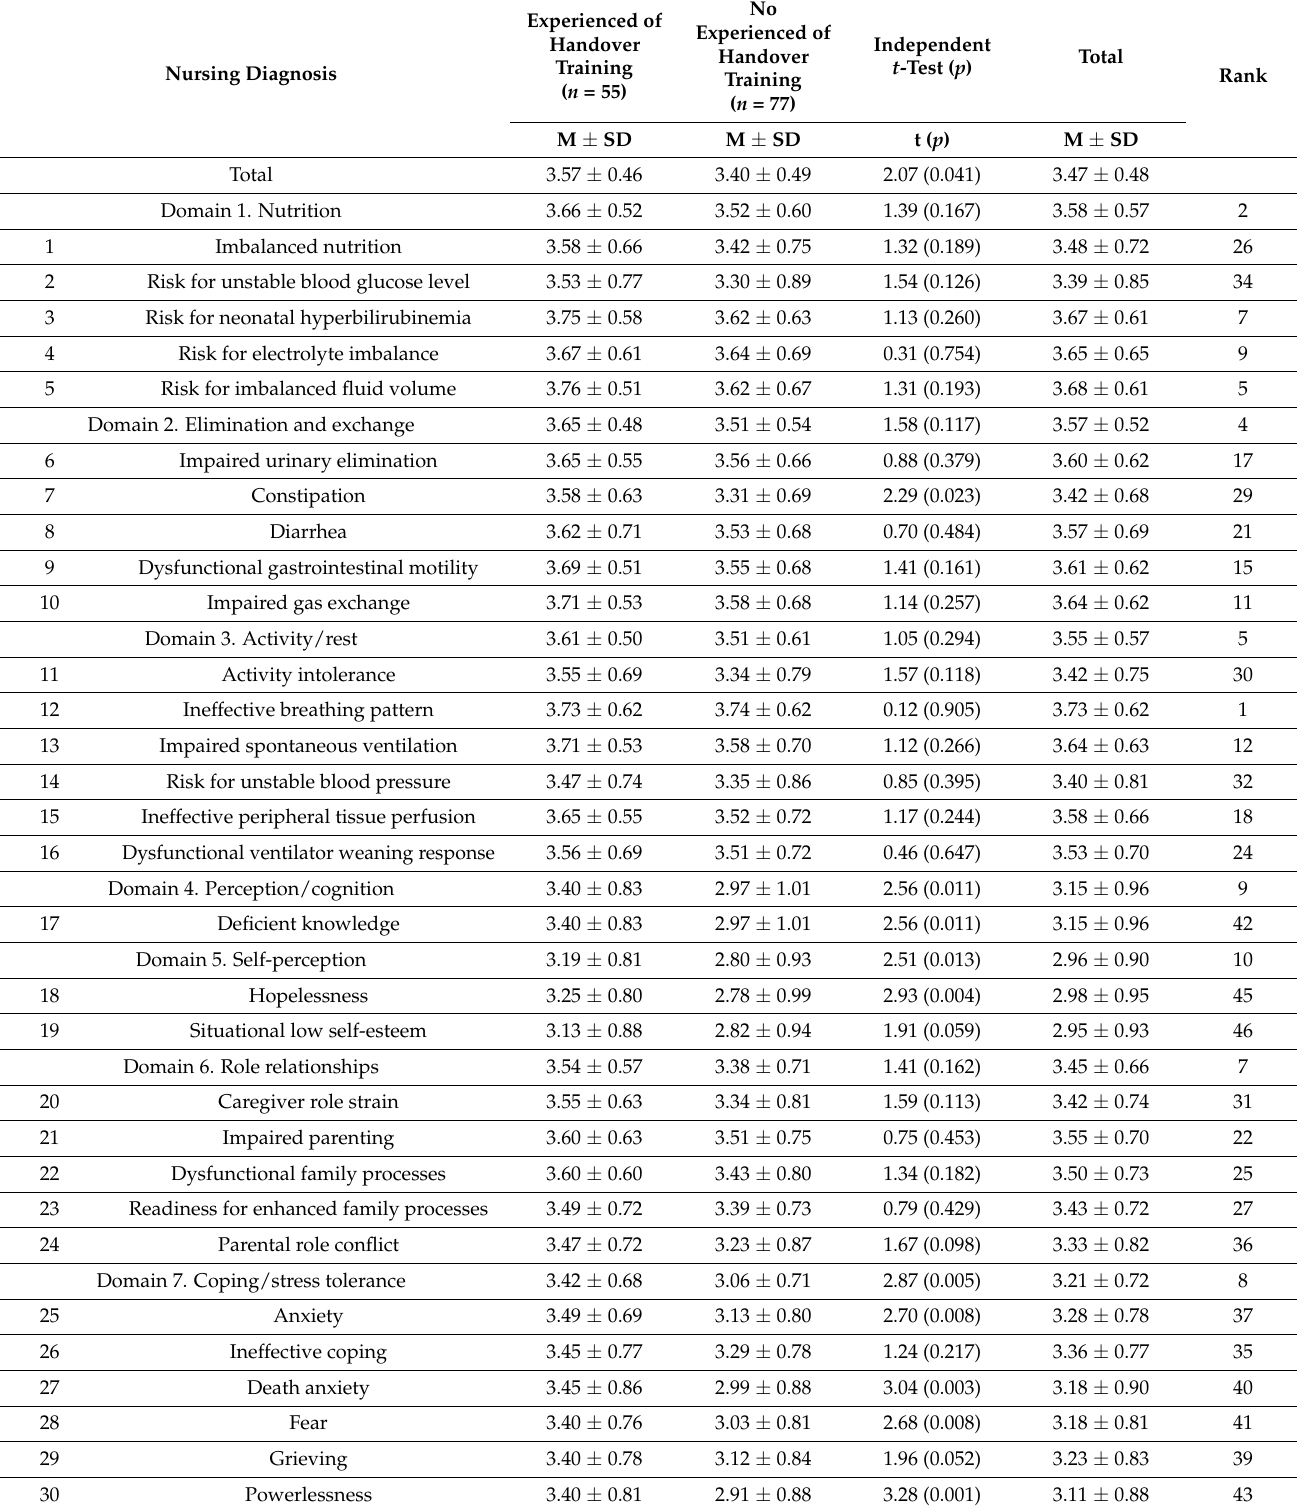
Table 4. Differences in the needs for handover training according to the presence or absence of neonatal nursing clinical field practice ( n =